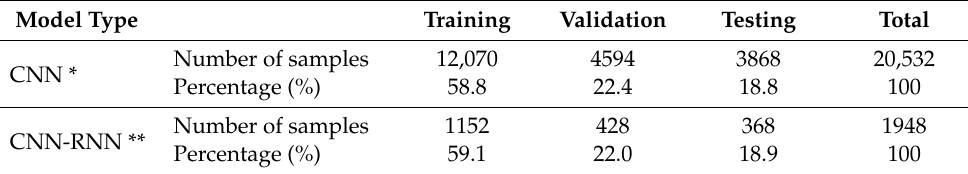
Table 2. The numbers of samples in training, validation, and testing groups. Model Type Training